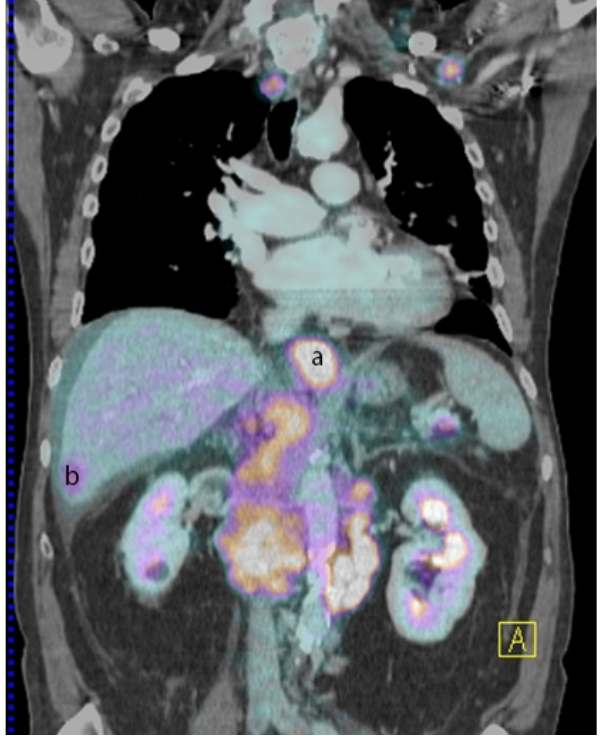
Figure 1. PET/CT, performed after administration of 311 MBq of Fludoxyglucose, showed increased activity in the lower oesophagus ( a ), liver metastasis ( b ) and pancreatic metastasis (not shown in the